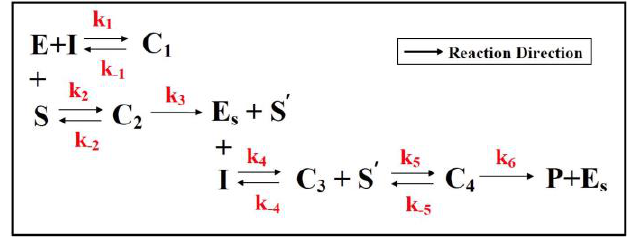
Figure 1. The schematic diagram of competitive inhibition reaction